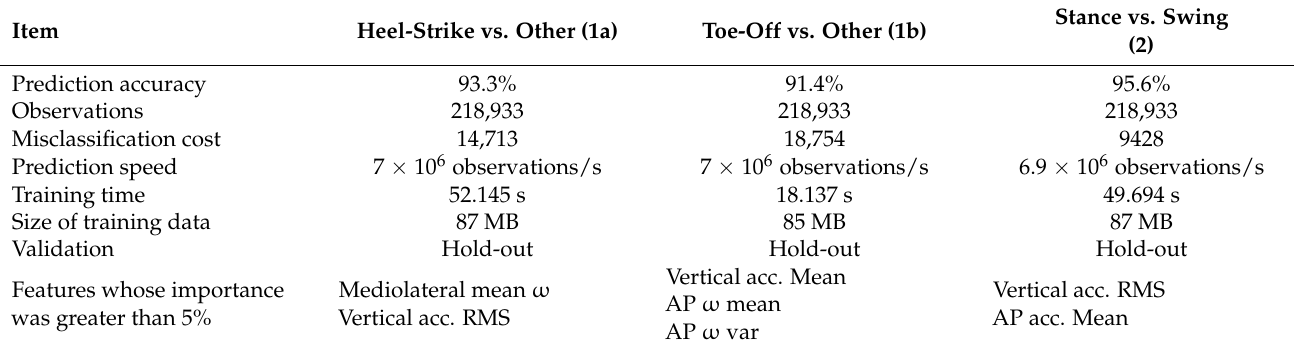
Figure 6. Classification performance of the three tested approaches. Left: heel-strike ( 1a ) and toe-off ( 1b ) events detection; Right: stance vs. swing moving windows classification ( 2 ). Table 2. Classifiers (decision trees) technical figures. The reported accuracy refers to the classification outcome, not to the final gait event estimation result. The outputs of Methods 1a and 1b were subsequently combined.